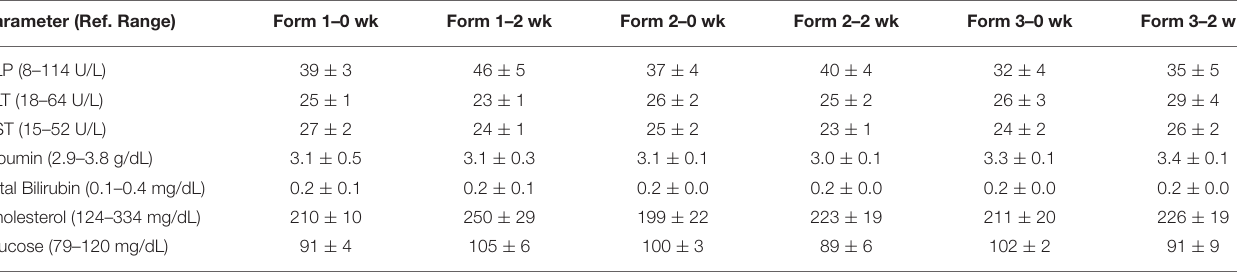
TABLE 2 | Mean and standard error of the mean concentrations ( n = 6) for hepatic biochemistry including ALP, ALT, AST, albumin, total bilirubin, cholesterol, and glucose at 0 and 2 weeks (wk). Parameter (Ref.